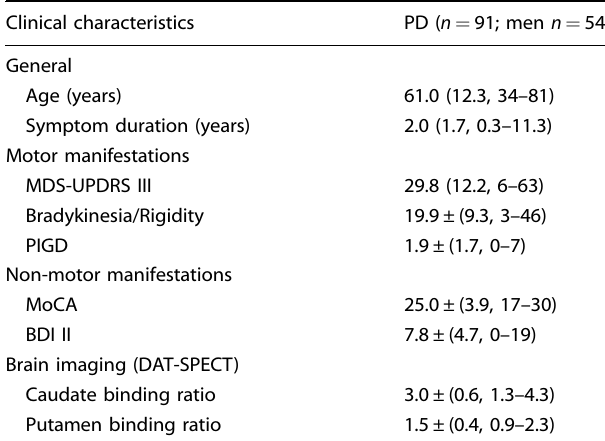
Table 1. The list of demographical and clinical information describing PD